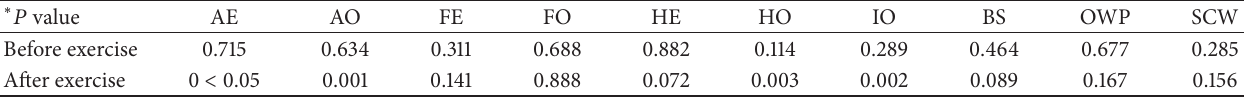
Table 3: The result of 𝑡 -test among exercise and control group in body-image subscales.